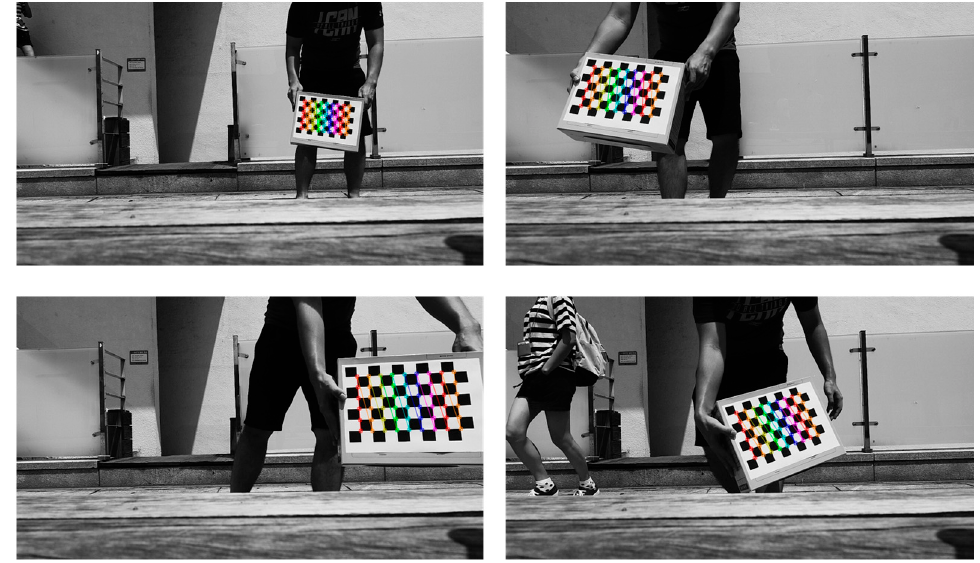
Figure 16. Some examples of our camera calibration process using chessboard pattern.